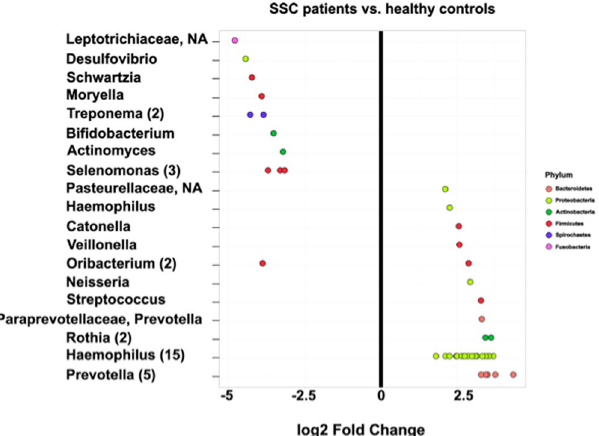
Figure 3. Pairwise comparison (DeSeq analysis). Differential abundant OTUs (p < 0.05) in SSC patients and healthy control counterpart samples are shown. OTUs were assigned to genus (y-axis) and phylum level (colours) and amount of respective OTUs (when > 1) are shown in brackets. Negative “log2 Fold Change” values (x-axis) indicate for higher abundance in SSC patient samples and positive values indicate higher abundances in healthy controls.